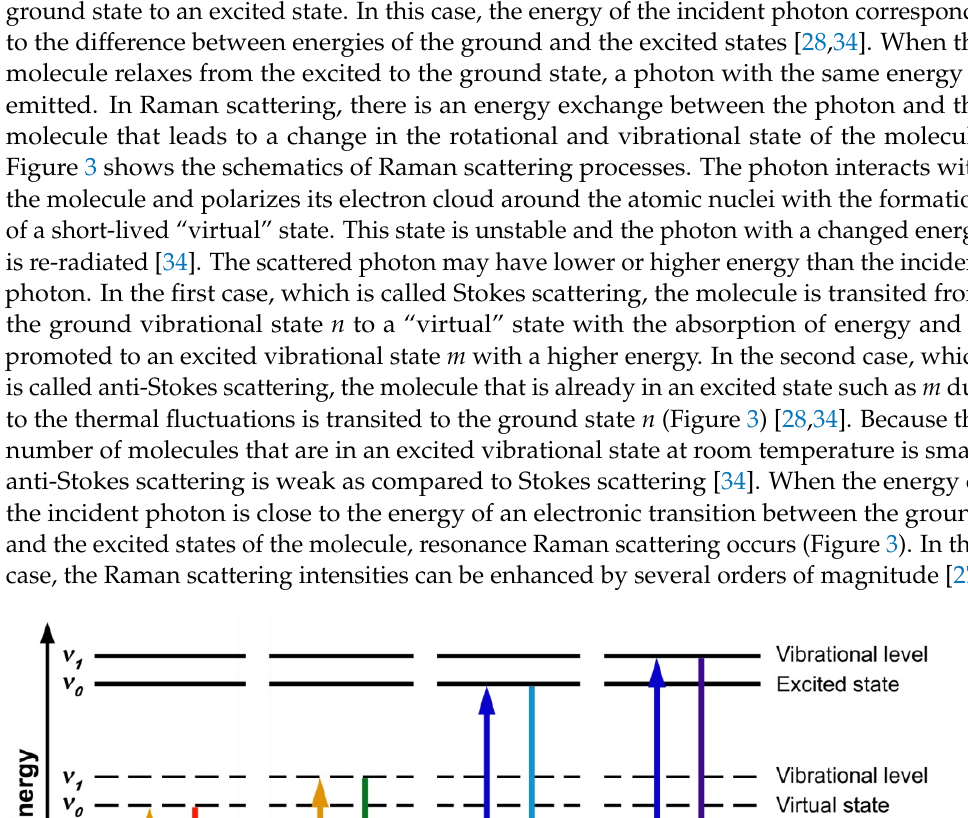
The Raman spectrum of SWCNTs contains four main regions: the radial breathing mode (RBM) at frequencies below 300 cm − 1 , which is assigned to radial vibrations of carbon atoms, the D-band at 1300–1400 cm − 1 , which is enabled at structural defects and dis- ordering, the G-band at 1500–1700 cm − 1 , which belongs to the longitudinal and transversal phonon and the 2D-band at 2500–2800 cm − 1 , which is the overtone of the D-line [64]. The RBM-band includes several peaks, whose positions ( ω RBM ) are inversely proportional to the SWCNT diameter by the